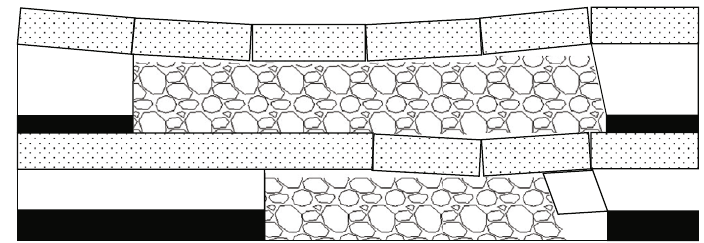
Figure 1: Basic roof fracture mechanics model of mining in a lower coal area.